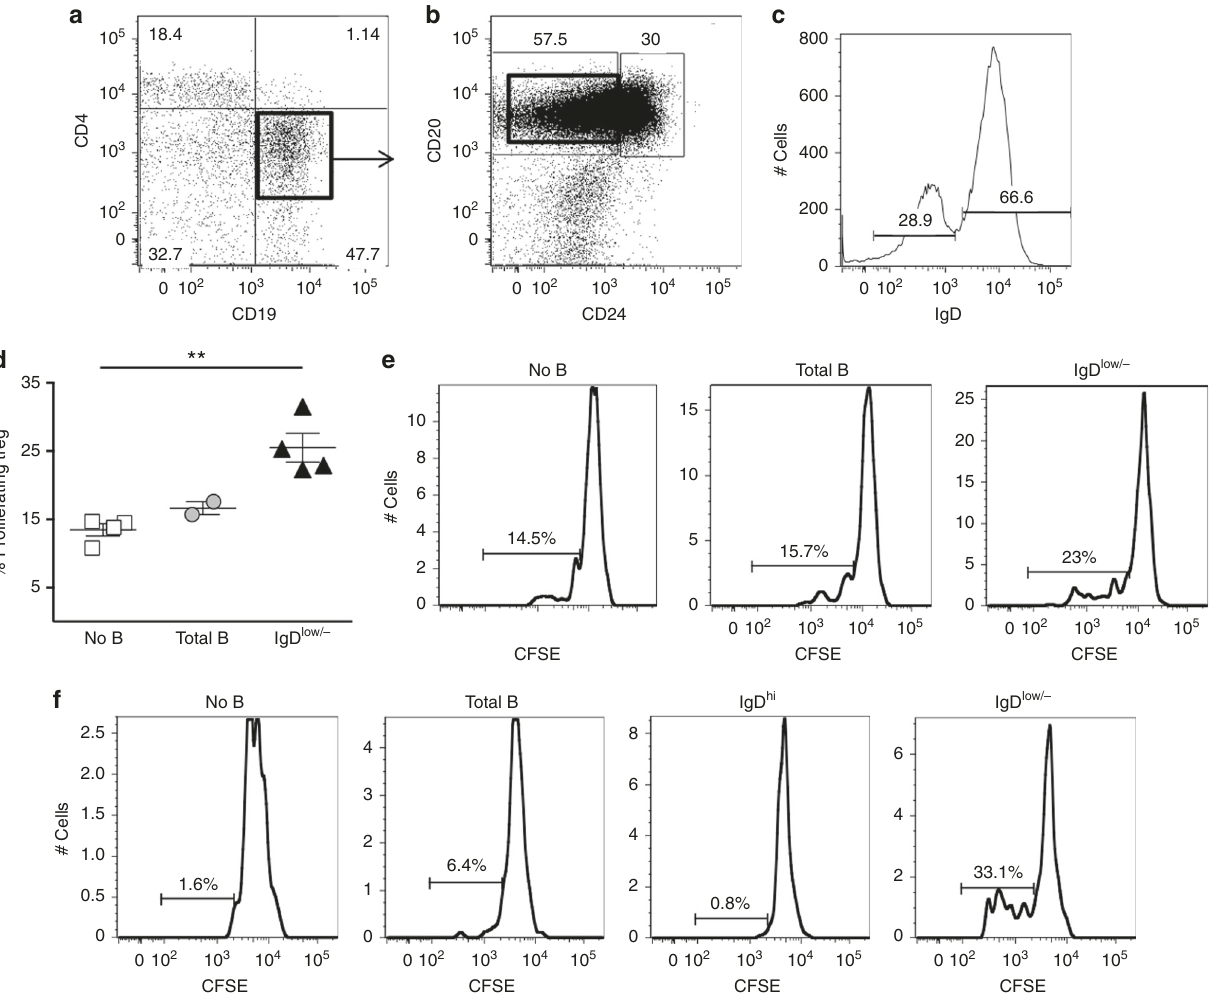
Fig. 9 Human IgD low/ − B cells induce the proliferation of human Treg in vitro. Human splenic B cells (CD19 + ) ( a ) and IgD low/ − (CD19 + CD20 + CD24 − IgD low/ − ) B cells ( a – c ) and Treg (CD4 + CD25 hi ) were FACS puri fi ed and the Treg were labeled with CFSE. d Treg (0.5 × 10 5 ) were cultured alone or with splenic B cells (1 × 10 5 ) in the presence of anti-CD3 (2 mg/ml) and irradiated APC (CD4 − CD8 − CD19 − ) for 96 h. Each symbol represents a single human sample. ** p < 0.01, no B cells vs. IgD low/ − . e Representative fl ow cytometry histograms with gating of proliferating cells is shown from one experiment of four from d . f Human peripheral blood B cells (CD19 + ), IgD hi (CD19 + CD20 + CD24 − IgD hi ) B cells, IgD low (CD19 + CD20 + CD24 − IgD low/ − ) B cells, and Treg (CD4 + CD25 hi ) were FACS puri fi ed. CFSE-labeled Treg (0.5 × 10 5 ) were cultured alone or with 1 × 10 5 total B cells, IgD hi , or IgD low/ − in the presence of plate bound anti-CD3 (10 mg/ml) and anti-CD28 (10 mg/ml). After culture, the cells were stained with CD4 and the percentage of proliferating Treg cells was determined by fl ow cytometry. Data shown are one representative experiment of two. Statistical signi fi cance was determined using the unpaired t